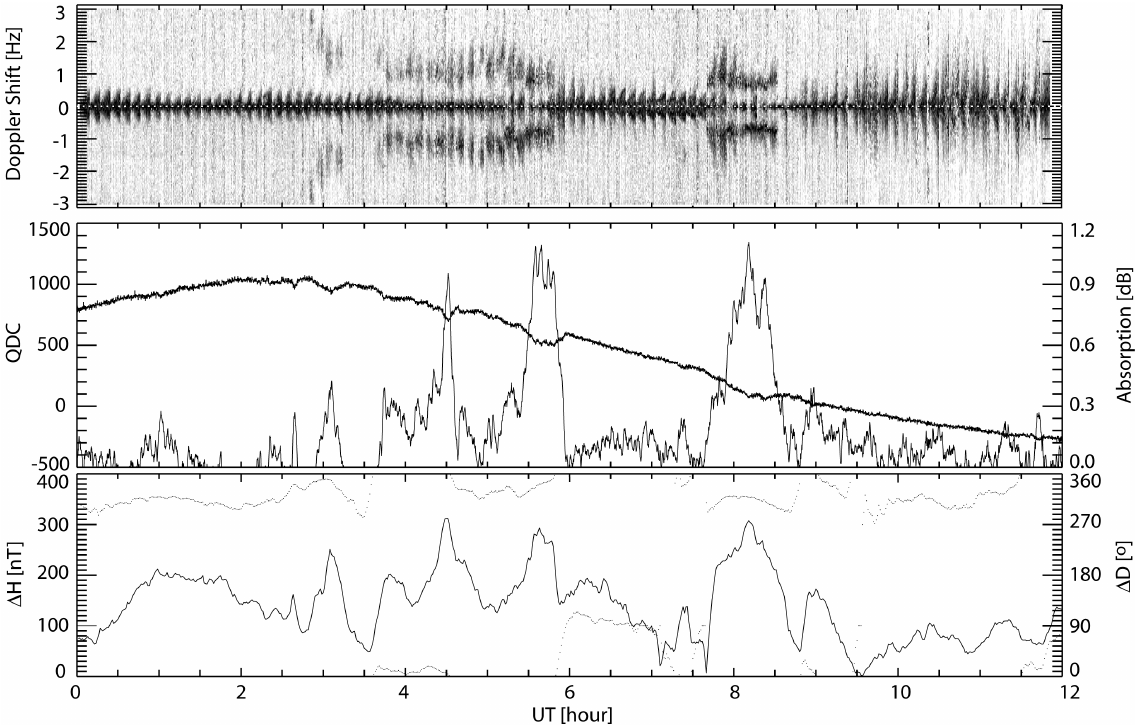
Fig. 8. E-region spectra, absorption and magnetic signatures during three successive SEC/lacuna events on 30 December 1996, starting at 03:00, 03:45 and 07:45 UT, respectively. The top window summarizes 12 hours of E-region drift spectra recorded on the central antenna of our four-antenna array interferometer. The middle window displays the corresponding quiet-day curve (QDC) of the co-located 30MHz riometer (thick line), together with absorption dB values (thin line). The bottom window shows coincident fluxgate magnetometer horizontal 1 H (continuous line) and declination 1 D (dotted line) components. 1 D is measured positive eastwards from geographic